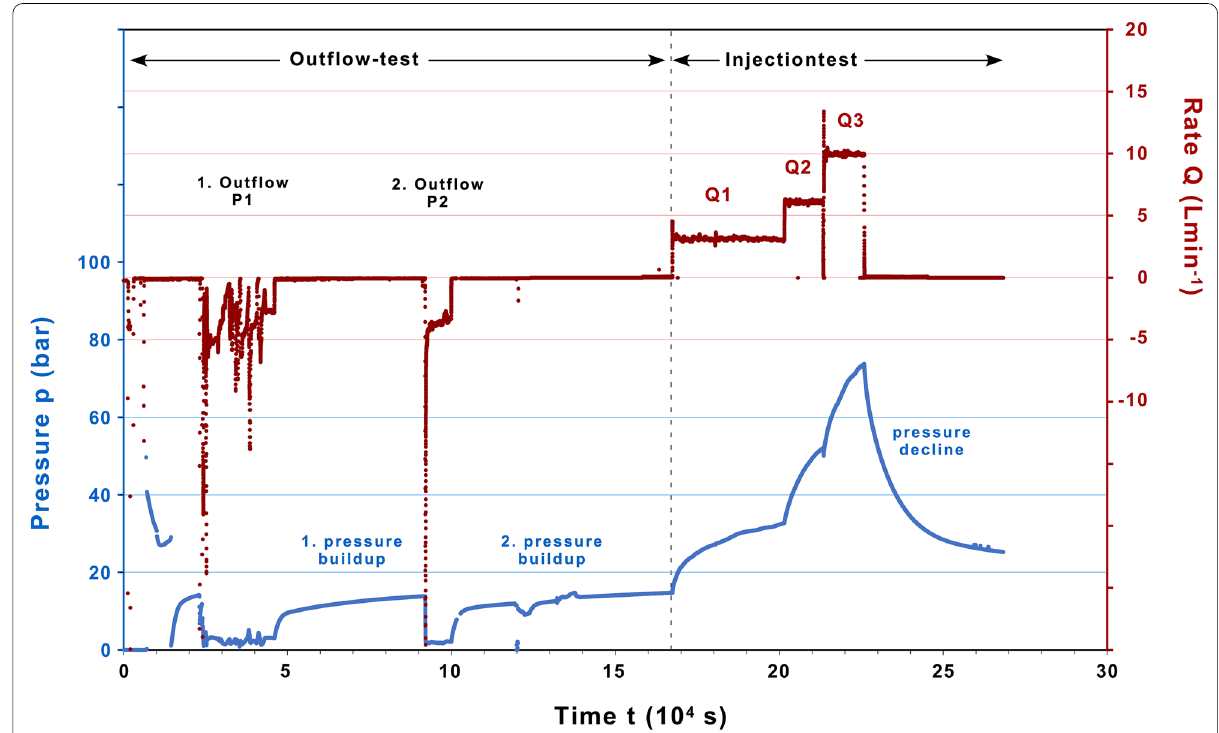
Fig. 3 Overview of the pre-test carried out in the Basel-1 borehole. Injection rates: Q 1